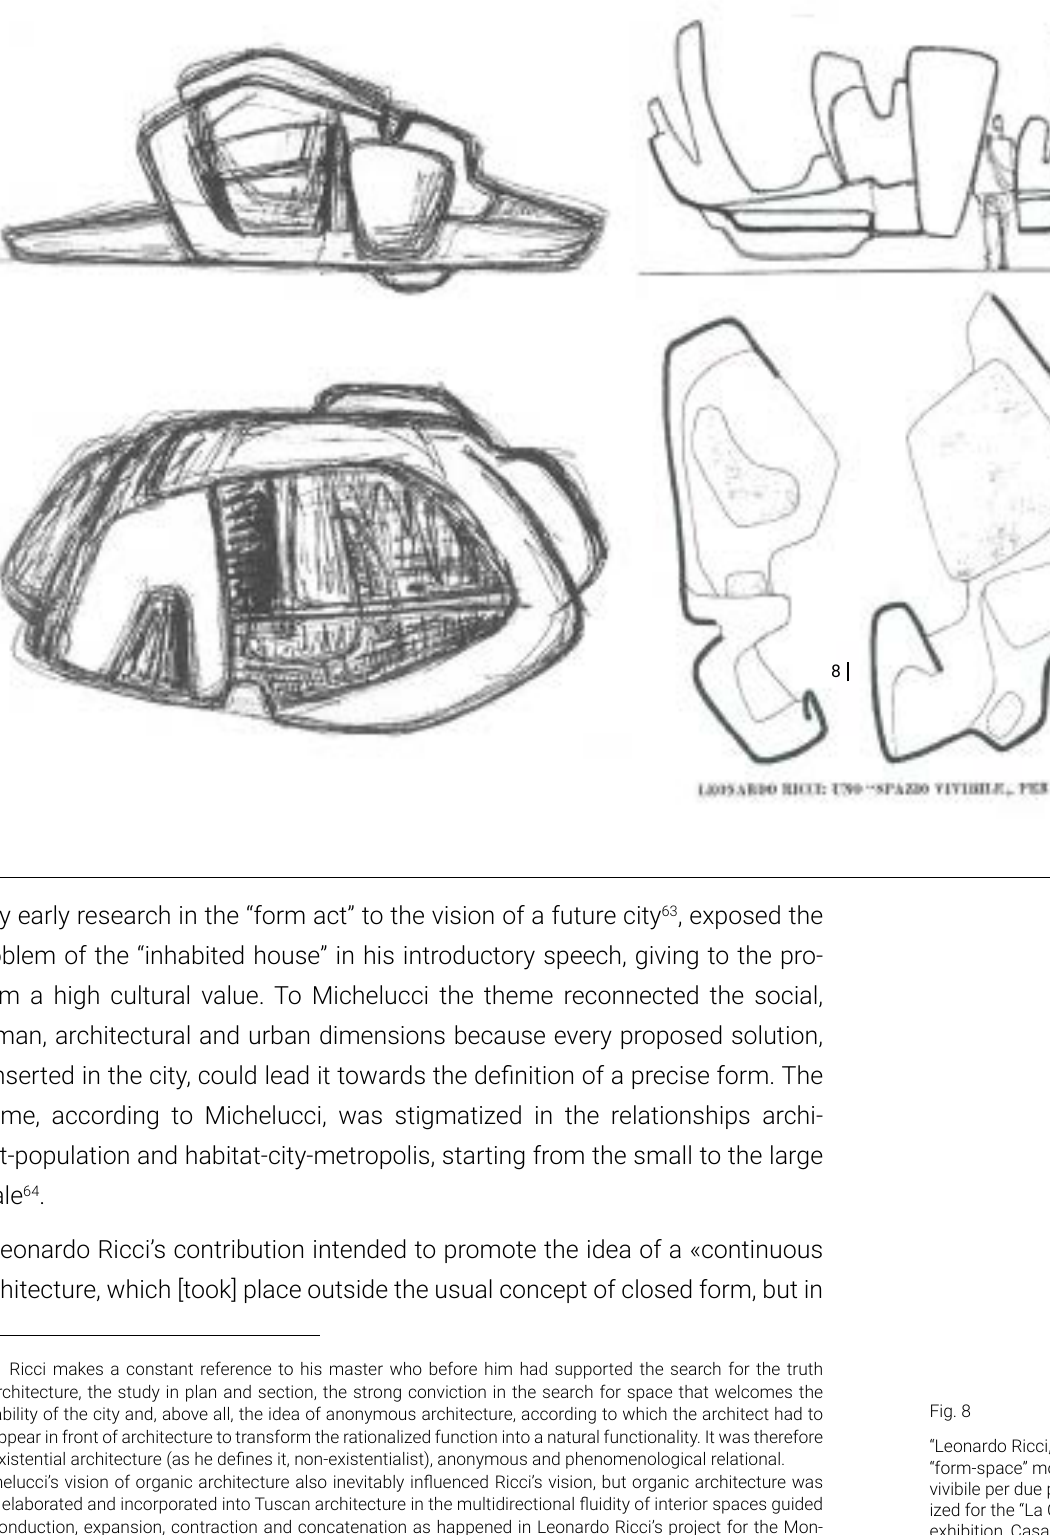
“Leonardo Ricci, sketch for the “form-space” model, “Spazio vivibile per due persone”, real- ized for the “La Casa Abitata” exhibition, Casa Studio Ricci; Leonardo Ricci, sketches and picture of the model for the “form-space” model, “Spazio vivibile per due persone”, real- ized for the “La Casa Abitata” exhibition, published in Lara Vinca Masini and Agnoldomen - ico Pica, “Intenti e Aspetti Della Mostra “La Casa Abitata”. Leon - ardo Ricci Uno “Spazio Vivibile” per Due Persone. La Casa Abitata: Arredamenti Di Quind- ici Architetti Italiani, La